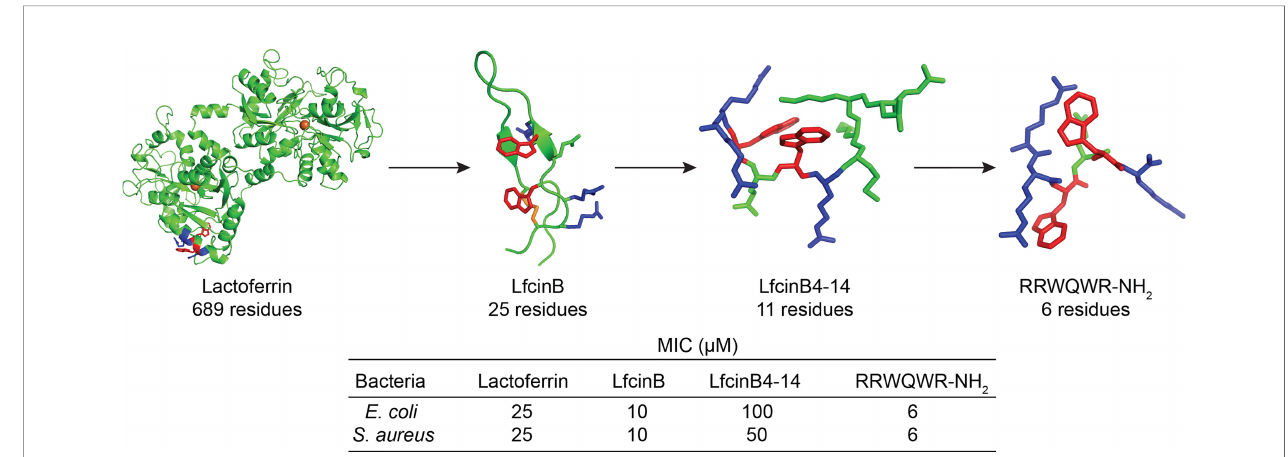
FIGURE 2 | Successful truncation of the native lactoferrin protein, 689 residues, [PDB: 1BLF (44)] via LfcinB, 25 residues [PDB: 1LFC (45)], LfcinB4-14, 11 residues [PDB: 1Y5C (46)], to the antibacterial RRWQWR-NH 2 motif (created and minimized in Pymol). Arg – red, Trp – blue, iron – orange ball, and disul fi de bond – orange stick). The N-terminal cyclic lactoferricin peptide is formed upon digestion and linearization and additional truncation of lactoferricin yields shorter sequences with maintained antimicrobial activity. MIC-values taken from Svenson et al. (47) and Tomita et al.